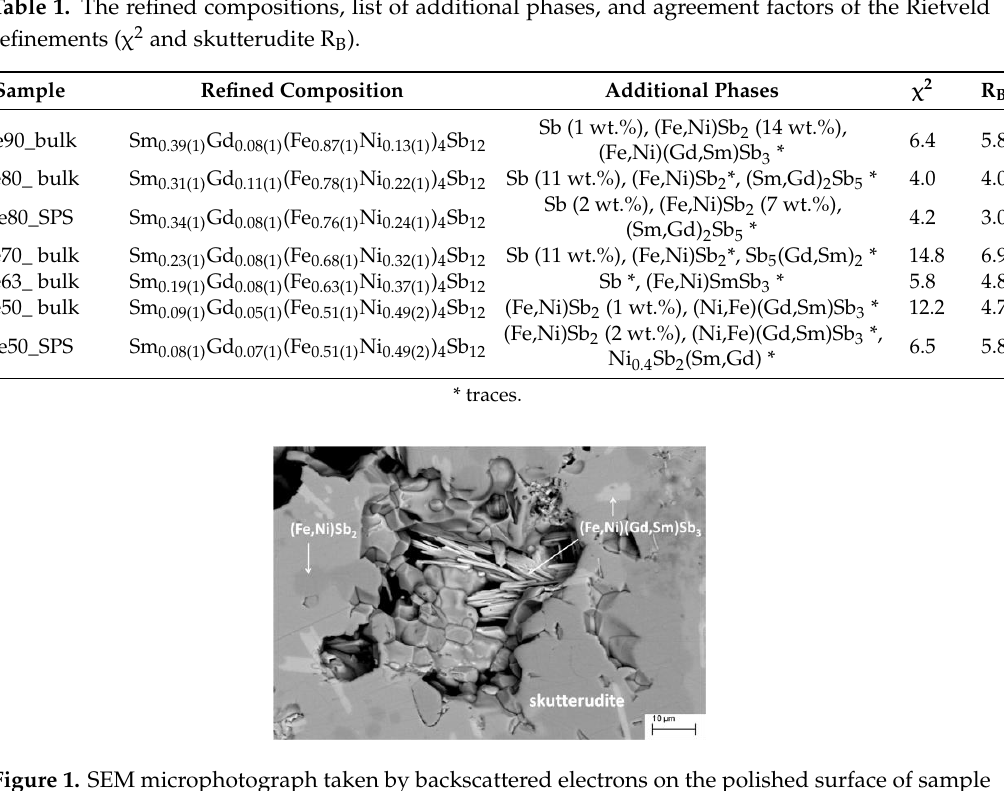
Table 1. The refined compositions, list of additional phases, and agreement factors of the Rietveld refinements ( χ 2 and skutterudite R B ).